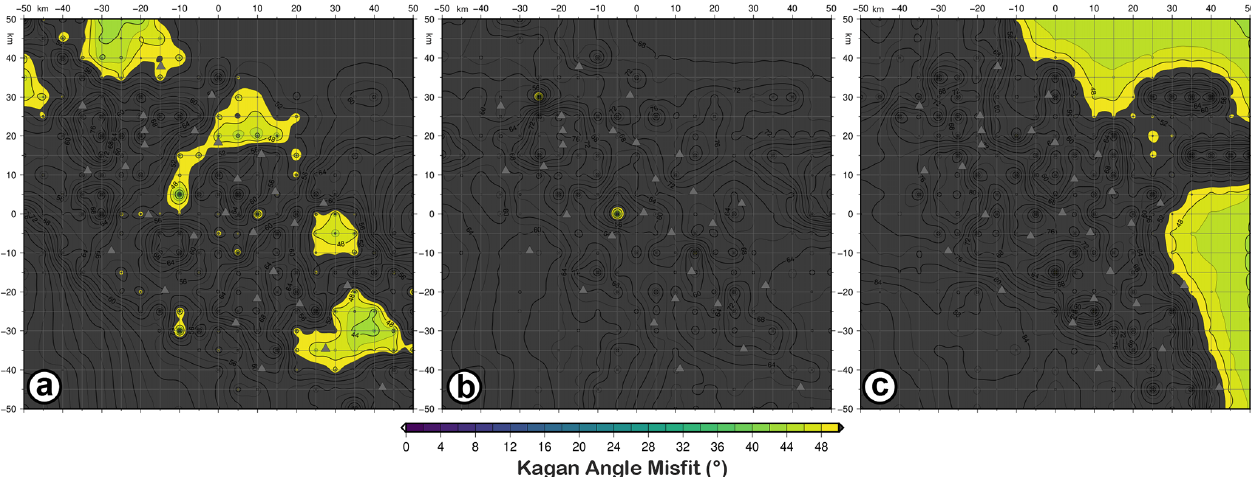
Figure 4. KAM (Kagan angle misfit) map for retrieved focal mechanisms with the D1 dataset as input data and simulating earthquakes with M3 magnitude and FM1 (a) , FM2 (b) , and FM3 (c) theoretical fault plane solutions at 10km depth.